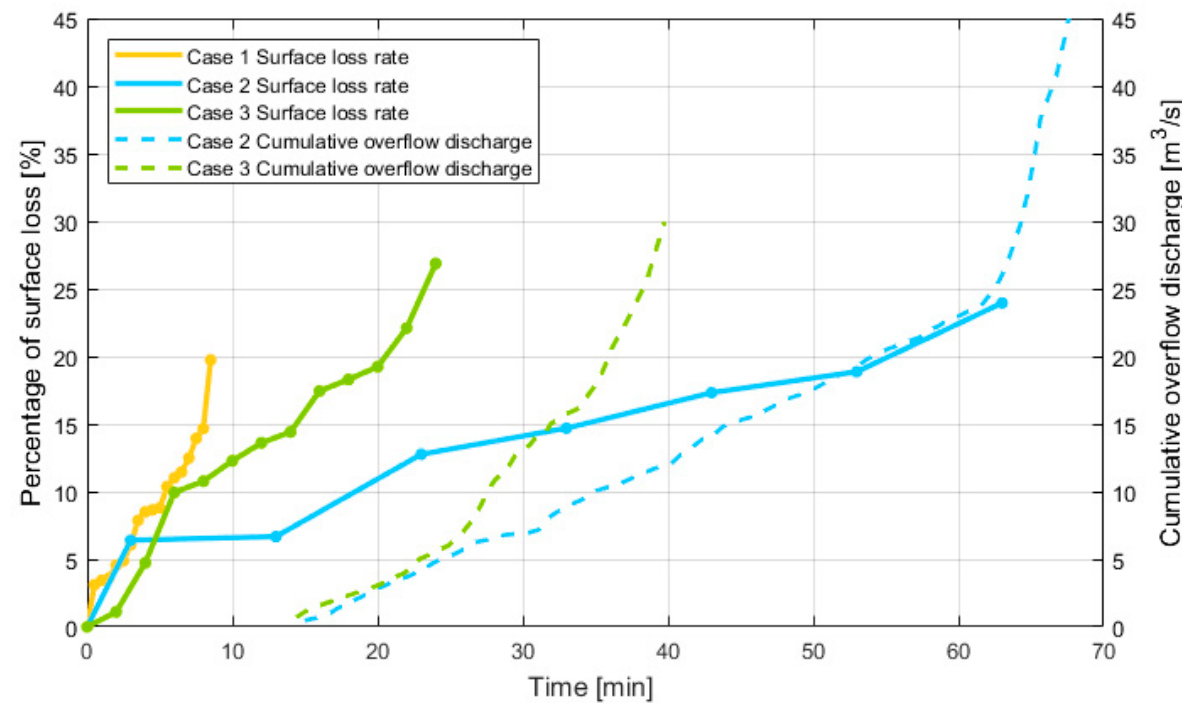
Figure 11. Comparison of the cumulative overflow discharge and surface loss rate over time.